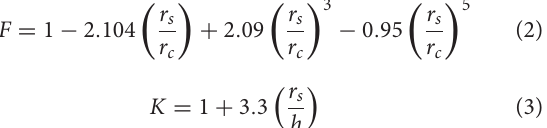
FIGURE 5 | Experimentally determined viscosities as a function of temperature for the green (circles), orange (triangles), and black (squares) glass compositions. In this high-temperature region, the green and black glasses exhibit Arrhenian behavior with activation energies ( E a ) determined from a linear fit to data using Eq. 4. Experimental data from Dygert et al. (2017) for a Fe-Ti lunar basalt are also shown, as well as the models of Dufils et al. (2018) for green and black glasses